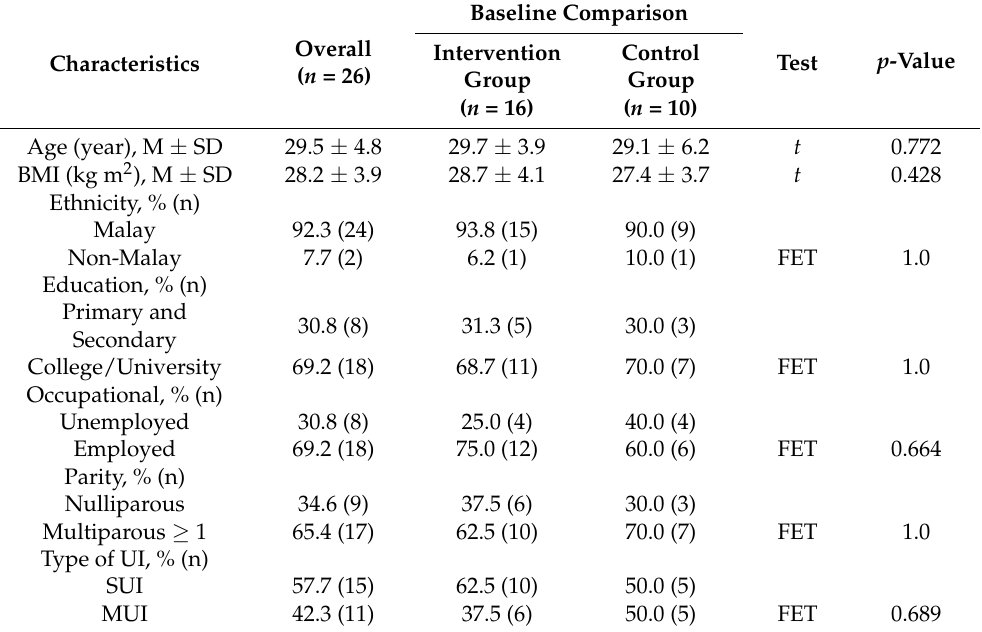
Table 3. Baseline characteristics of the intervention vs. control